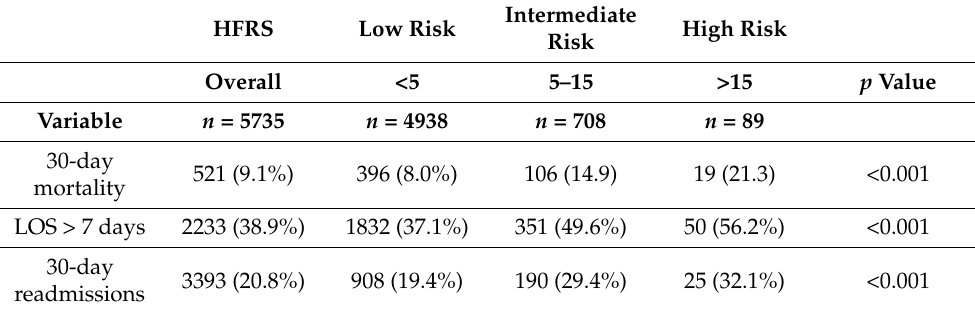
(Table 1). The clinical outcomes in the three HFRS frail groups are presented in Table 2. Table 2. Clinical outcomes by HFRS category. HFRS Low Risk